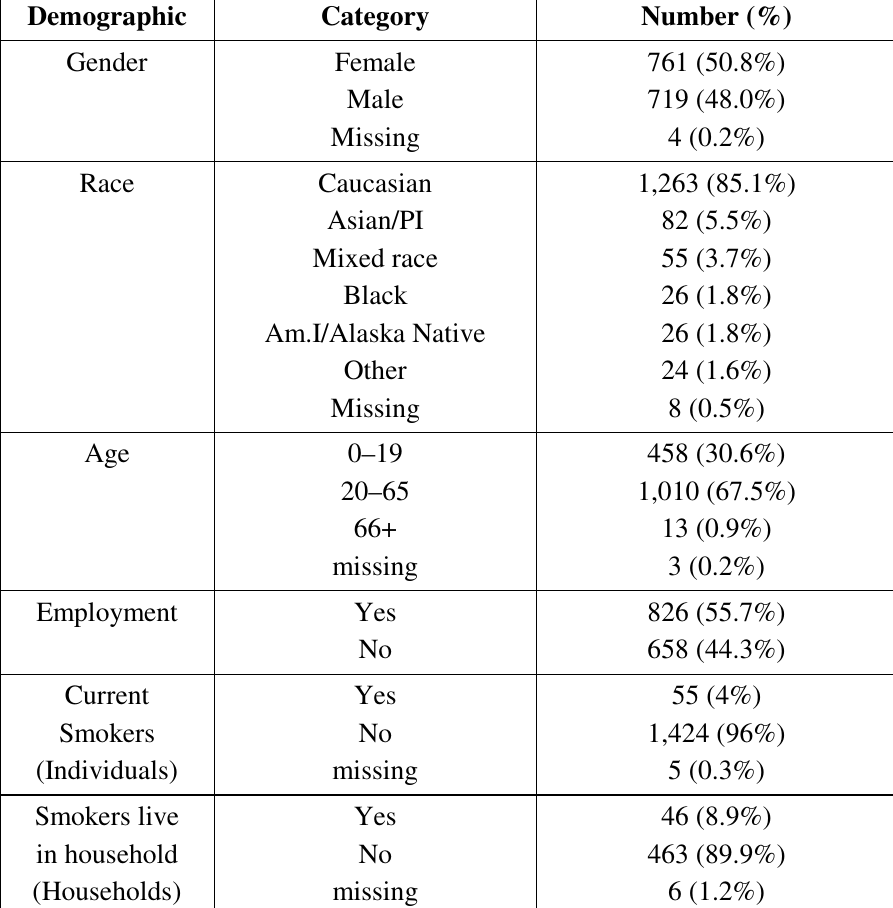
Table 1. Demographics of the